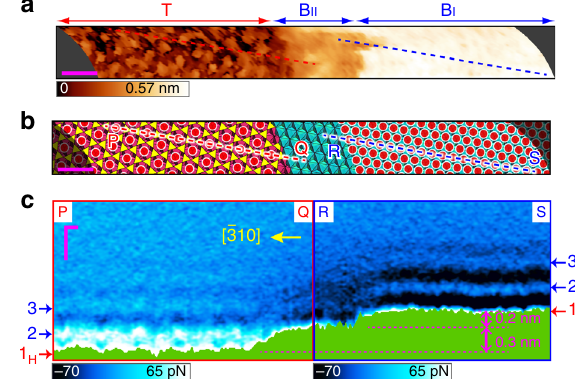
Fig. 4 Experimental local hydrations around the step edge. a , b Topographic image ( a ) and structural model ( b ) of the clinochlore (001) surface reconstructed from 3D Δ f data ( Δ f = 290 Hz). Red dots represent the adsorbed water molecules on the fi rst layers on the T and B I regions. c Perpendicular 2D force maps extracted from the 3D force data along the broken lines P – Q and R – S in a . Scale bars: 1 nm ( a , b ) and 0.3 nm ( c